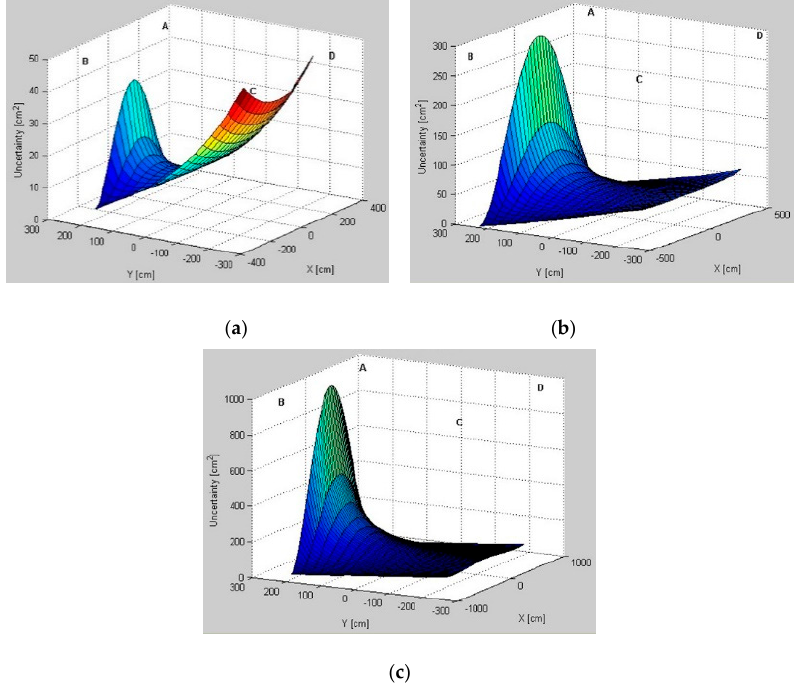
Figure 6. Uncertainty distributions for location sensors AB in ( a ) test environment TE1 ; ( b ) test environment TE2 ; and ( c ) test environment TE3 .